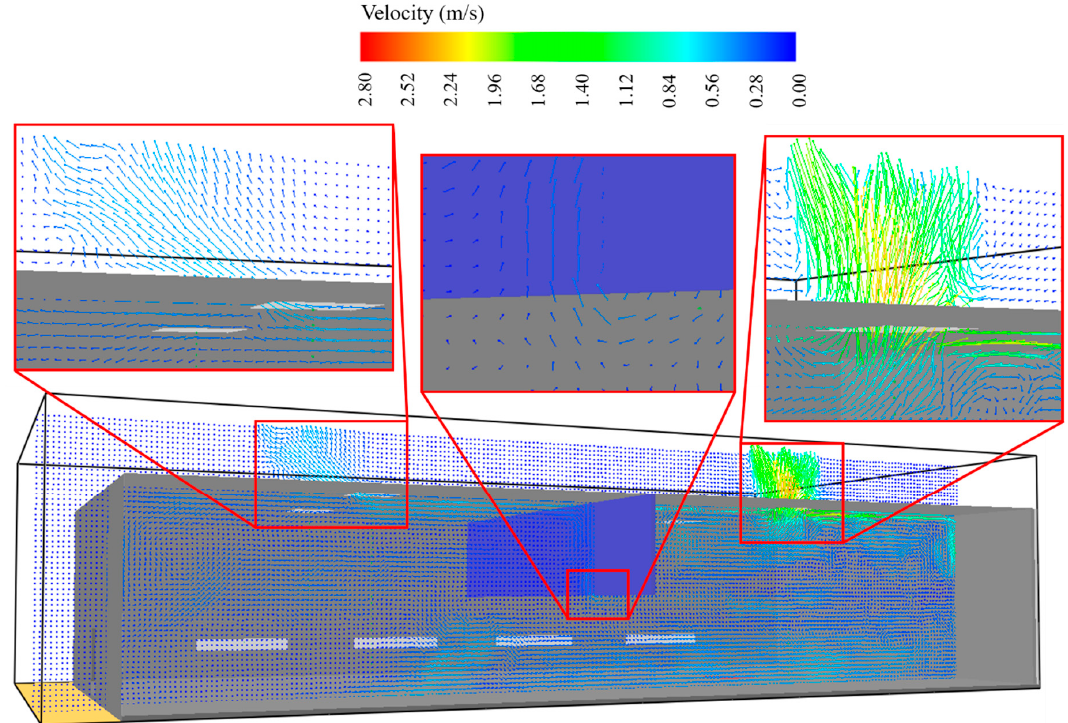
Figure 15. Velocity vector field in a plane that crosses two exhaust vents (y = 3.75 m) at time t = 600 s (case 10).